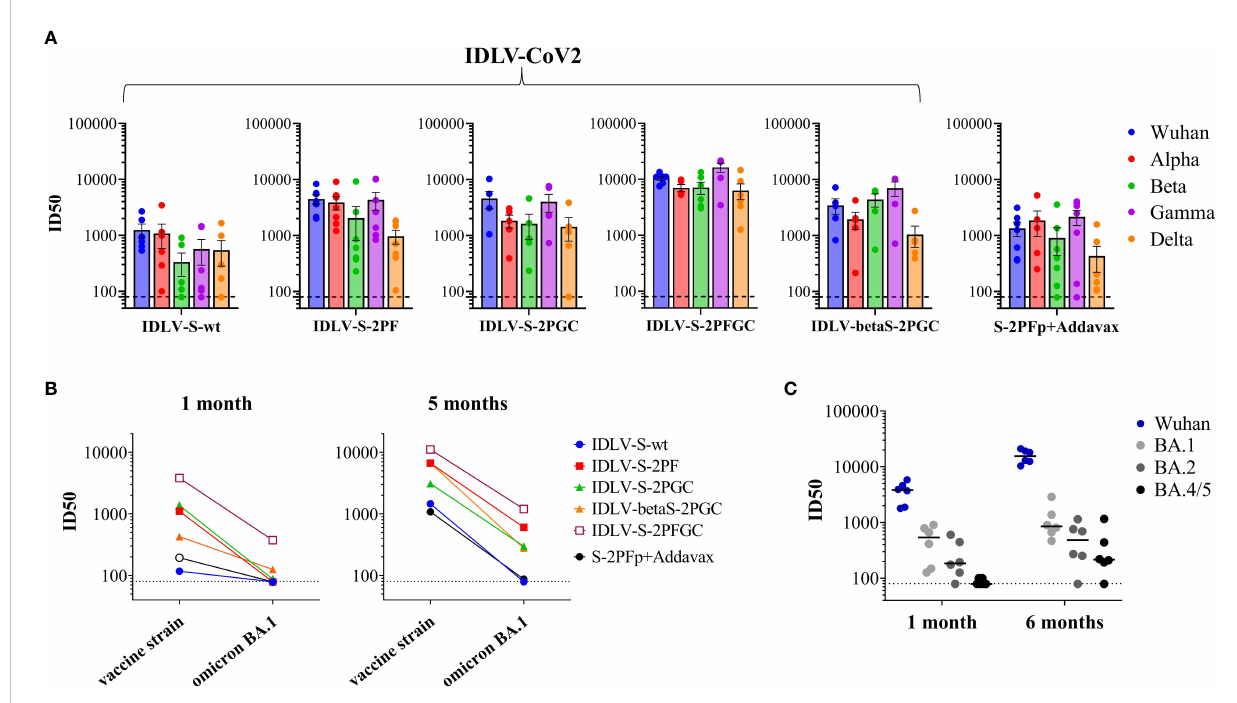
FIGURE 5 Cross-neutralization with VoC. (A) NAbs against each VoC were measured in serum samples collected at 4-5 months after immunization with HD vaccines, using LV-Luc pseudotyped with Spike from the indicated VoCs. Results are expressed as mean ID50 ± SEM. Each dot represents a single mouse. (B) Serum samples from early and late time points after immunization with HD vaccines were analyzed for cross-neutralization against the Omicron BA.1 variant. Results are expressed as median ID50. (C) Sera from IDLV-S-2PFGC were assayed for cross-neutralization against Omicron VoC at early and late time points after vaccination. Each dot represents a single mouse. The black line indicates the median ID50. The dotted lines indicate the assay cut off (minimum serum dilution tested 1:80